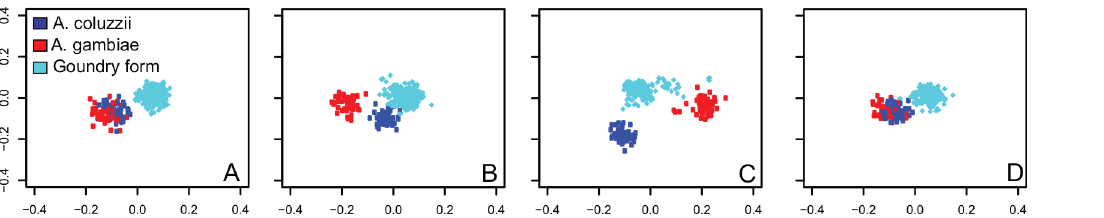
Fig 4. Sliding window PCA indicates that differentiation between A . coluzzii and A . gambiae is restricted to centromeric chromosome regions. Chromosome 3 is analyzed as four non-overlapping windows of 115 uniformly spaced SNPs each, as follows: A) Telomeric and central region of chromosome 3R, B) centromeric region of chromosome 3R, C) centromeric region of chromosome 3L, and D) central and telomeric region of chromosome 3L. Sliding window analysis indicates that A . coluzzii (blue) and A . gambiae mosquitoes (red) cluster together as an apparently panmictic population when typed using non-centromeric markers. In contrast, the Goundry form (turquoise) is distinct from A . coluzzii and A . gambiae across the entire length of both chromosome arms, at both centromeric and non-centromeric sites.